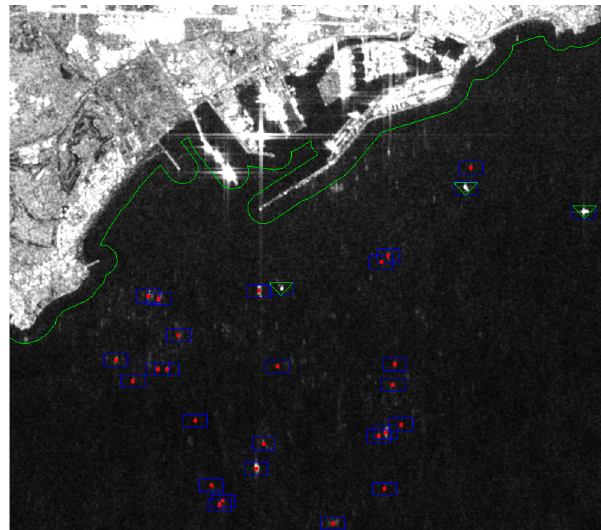
Figure 8. Area in front of the port of Tarragona, VV channel. Almost all of the echoes on the water are due to azimuth ambiguities from land reflectors. The ones that are bright enough to have been detected by SUMO are indicated with a blue rectangle (detected in VV) and/or a green triangle (detected in VH); but the red dots indicate the ones that were automatically recognized as azimuth ambiguities. The only three detected real targets were detected in cross-pol and are a buoy (center) and two ships (top right). Orientation as in the previous figure.